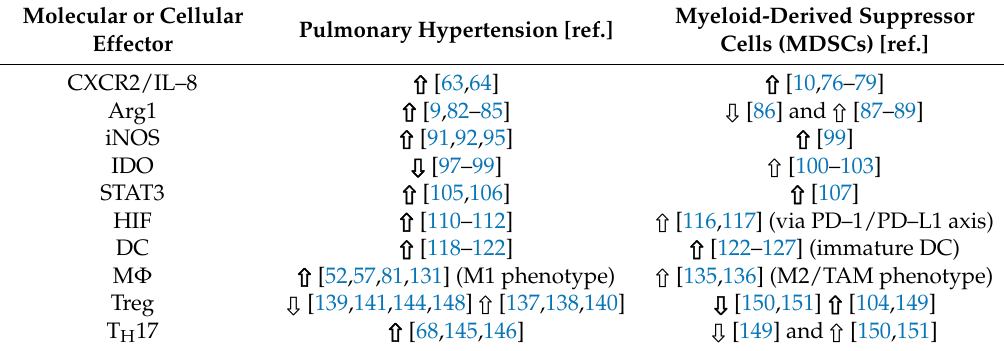
Table 1. Comparison of potential effectors in disease pathogenesis of pulmonary hypertension (PH) and myeloid-derived suppressor cell (MDSC) mediated pathology.